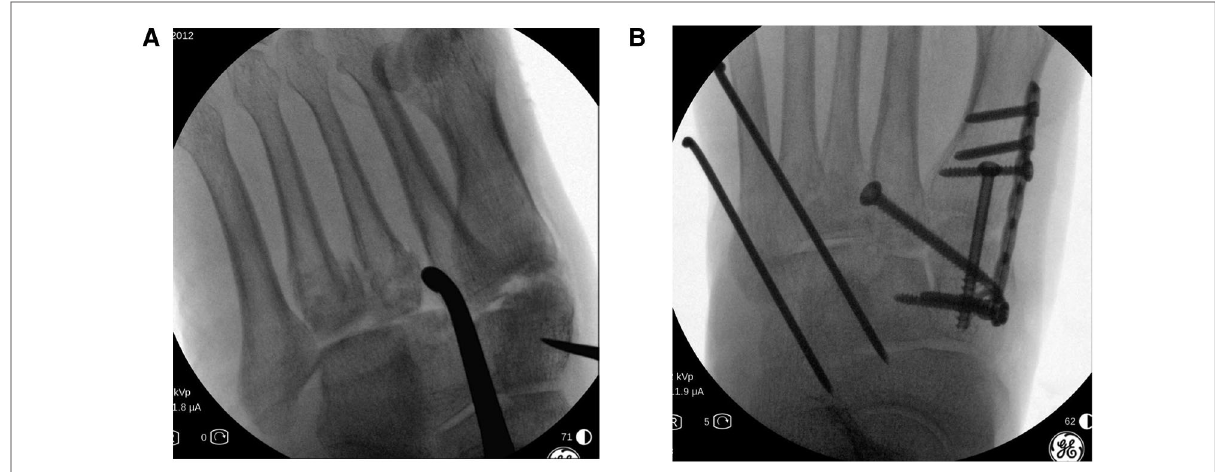
FIGURE 6 Intraoperative fl uoroscopy. The patient ’ s fi rst metatarsophalangeal joint surface is crushed; thus, fusion surgery was performed. The dislocated fourth and fi fth metatarsophalangeal joints were dif fi cult to reduce, resulting in signi fi cantly increased operative time and intraoperative fl uoroscopy. ( A ) Intraoperative C-arm machine to monitor the metatarsophalangeal joint reduction. ( B ) Postoperative lateral and anteroposterior radiographs,